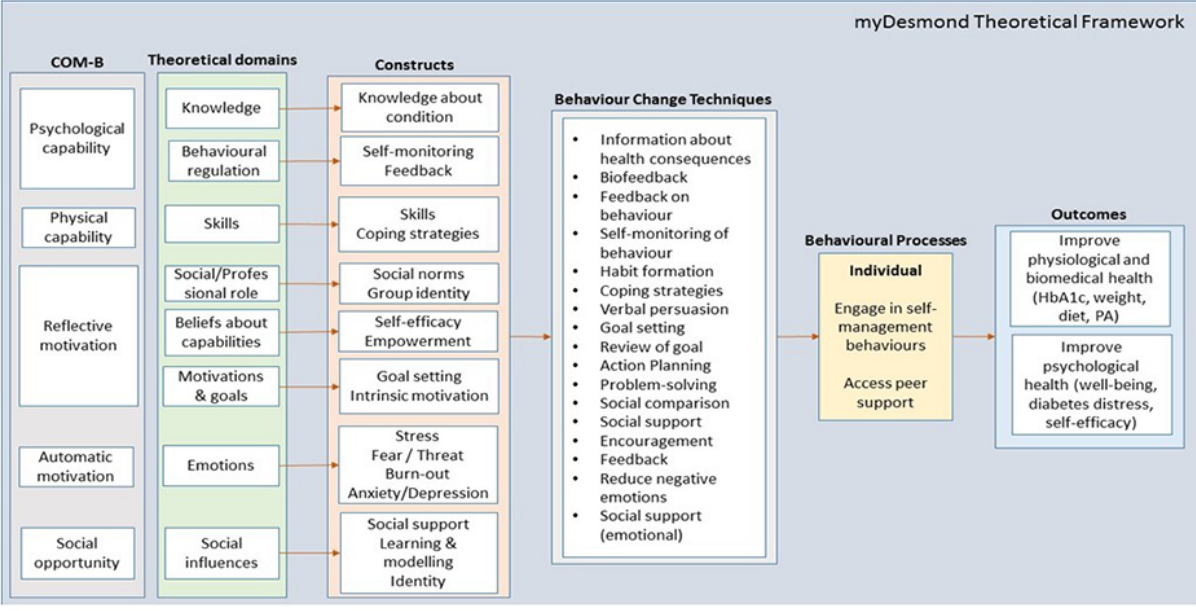
Figure 3. MyDESMOND theoretical